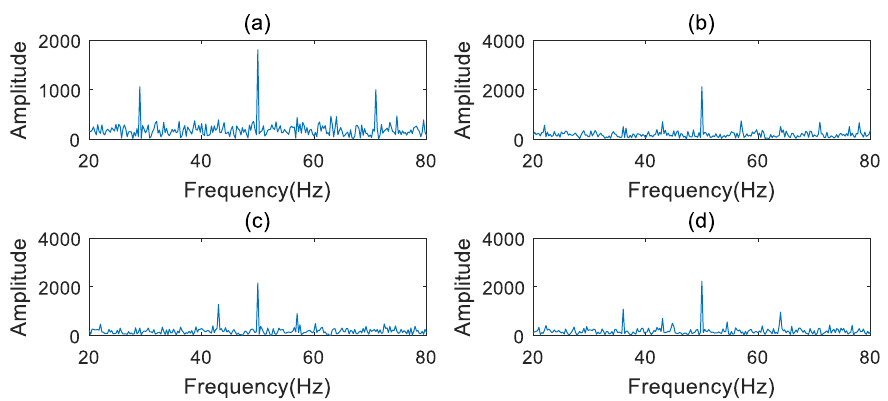
Figure 2. Waveforms of simulation signal: ( a ) Group a; ( b ) Group b; ( c ) Group c; ( d ) Group d.